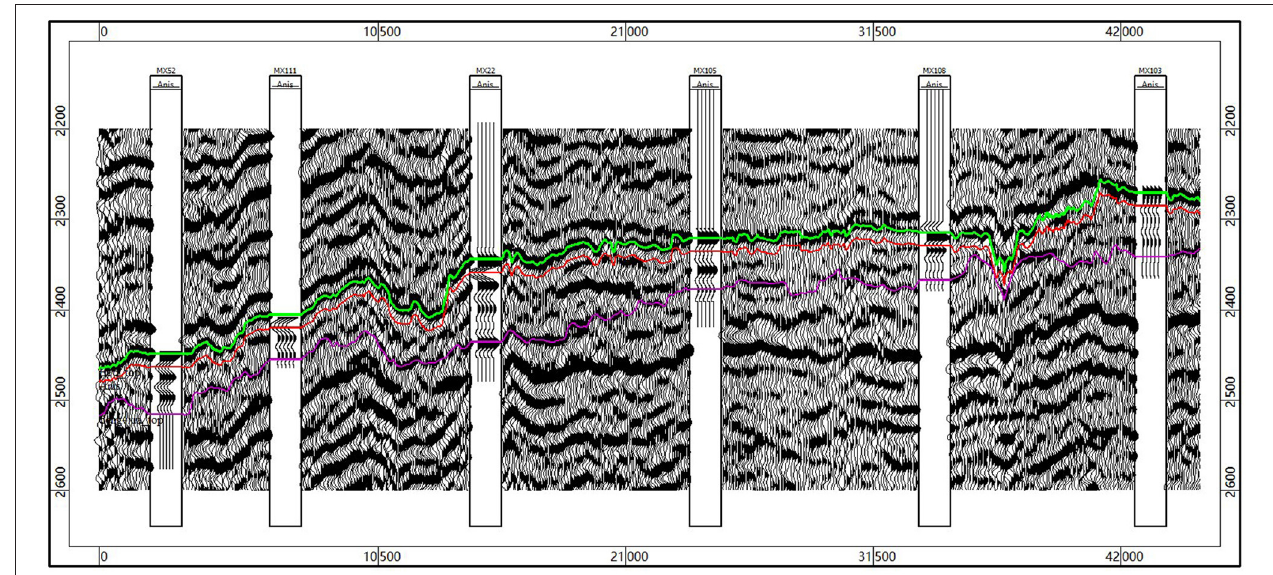
FIGURE 7 | Cross-well seismic section.